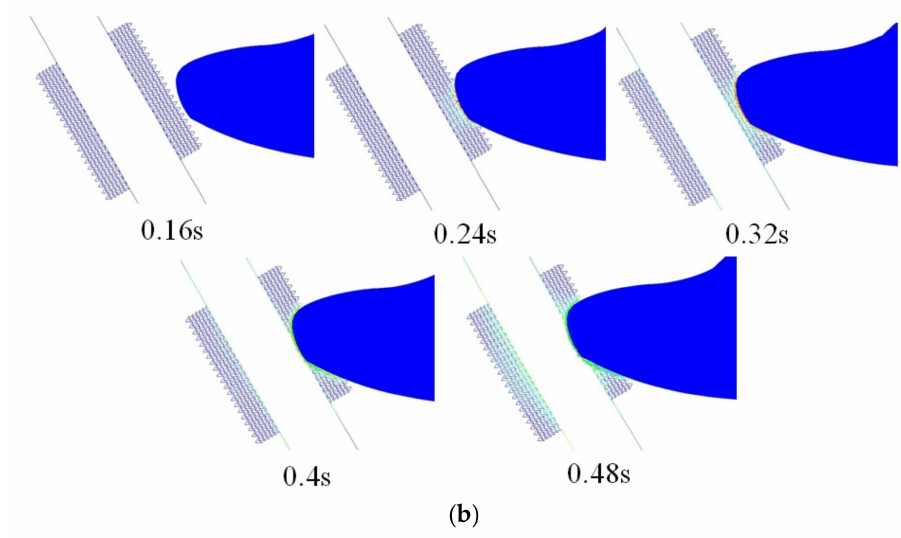
Figure 15. Cross-section view of the two honeycomb reinforced pipes during collision. ( a ) hexagonal honeycomb structure; and ( b ) arrow honeycomb structure.